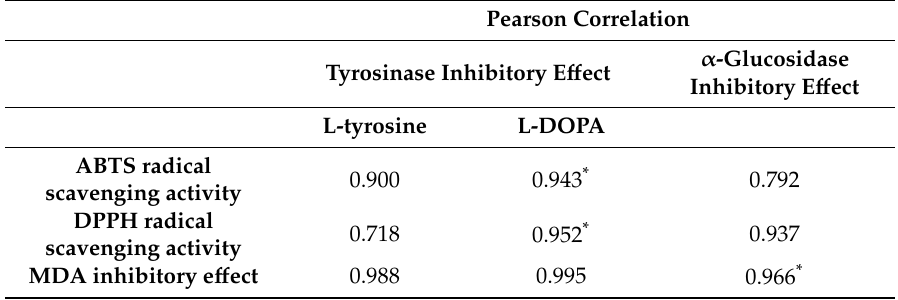
Table 1. Correlation between antioxidant activity and inhibitory e ff ect of melanogenesis- mediated enzyme Pearson Correlation α Tyrosinase Inhibitory E ff ect